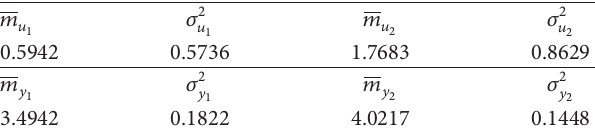
Table 2: Statistical average values of the controllers and the outputs